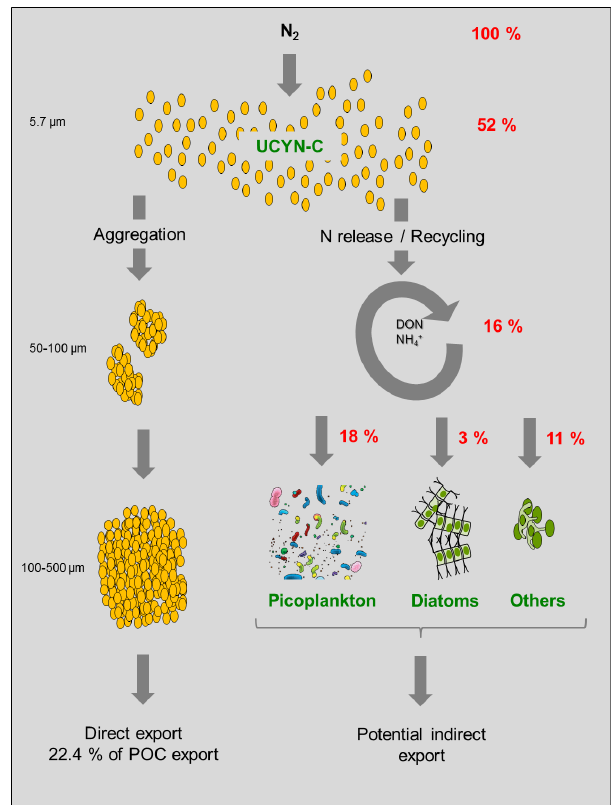
Figure 7. Summary of the simplified pathways of N transfer in the first trophic level of the food web and the potential impact on the sinking POC flux at the height of the UCYN-C bloom in the VAHINE mesocosm